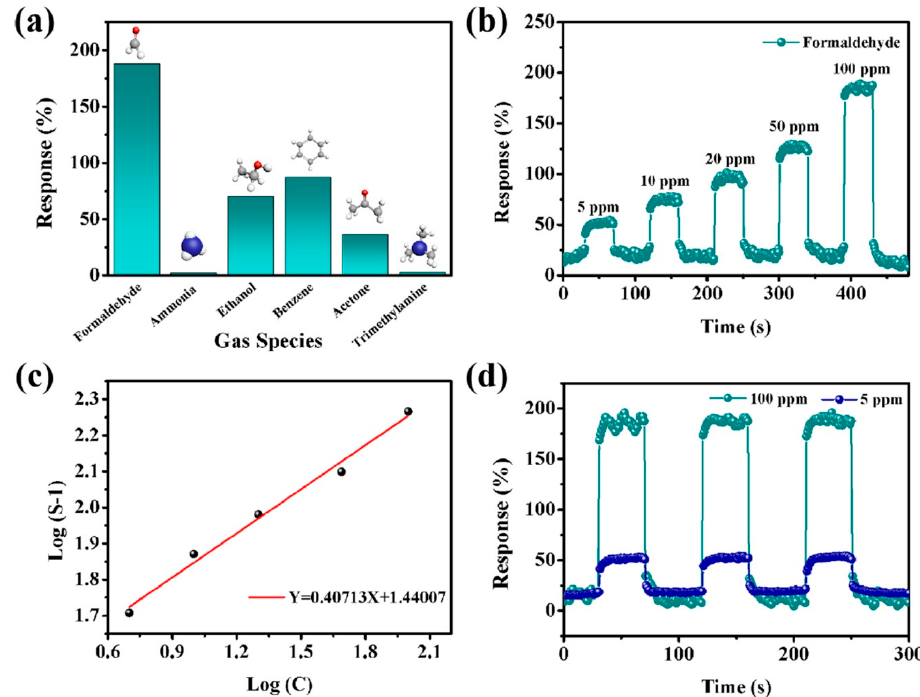
Figure 24. (a) Selective curve of the ZnSnO 3 /Ti 3 C 2 T x composite to 100 ppm of various gases at RT. ( b ) Dynamic response curves for 5–100 ppm formaldehyde, and ( c ) corresponding function fitting plots of sensors at RT. ( d ) cyclic response of ZnSnO 3 /Ti 3 C 2 T x composites to 5 and 100 ppm formaldehyde at RT. Reprinted with permission from [127]. Copyright 2022: Elsevier B.V.